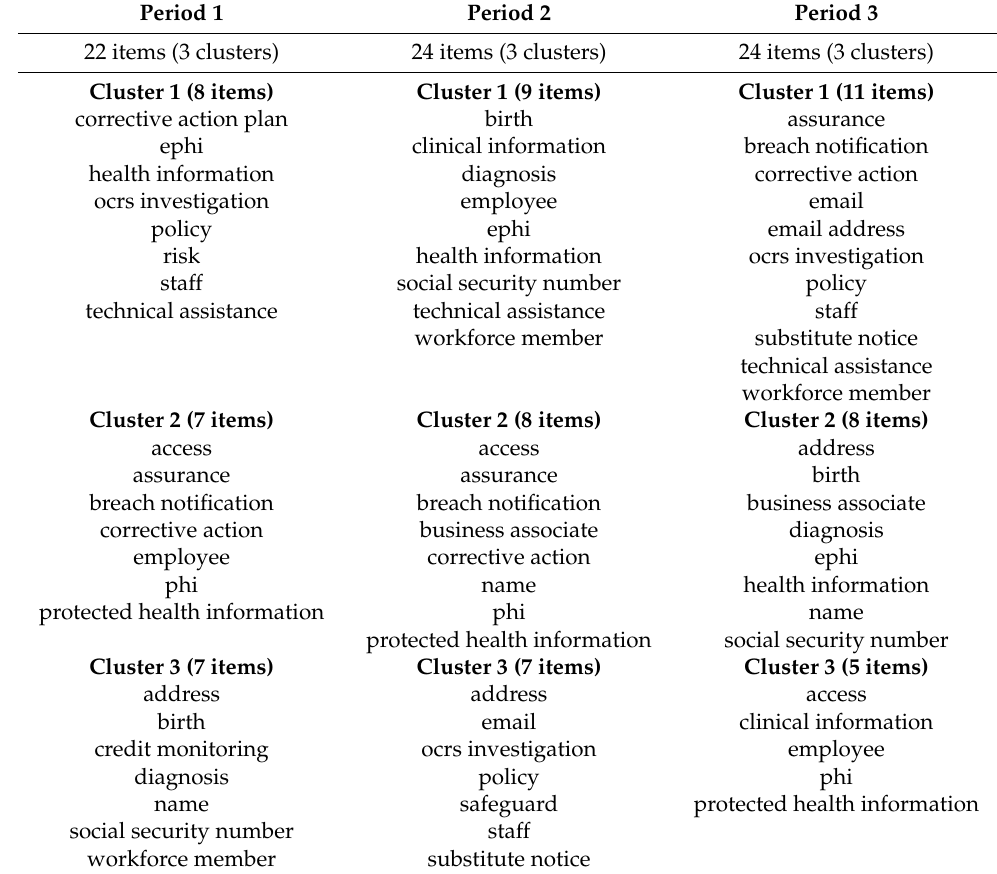
Table 5. Clusters of Keyword co-occurrences of Unauthorized Access/Disclosure in Three Periods.